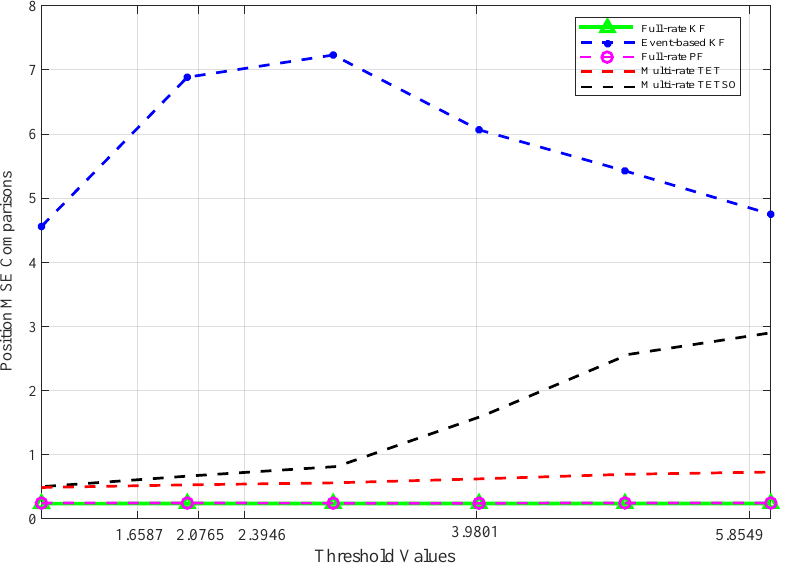
Figure 5. The MSE comparison across communication rates achieved by TETSO.